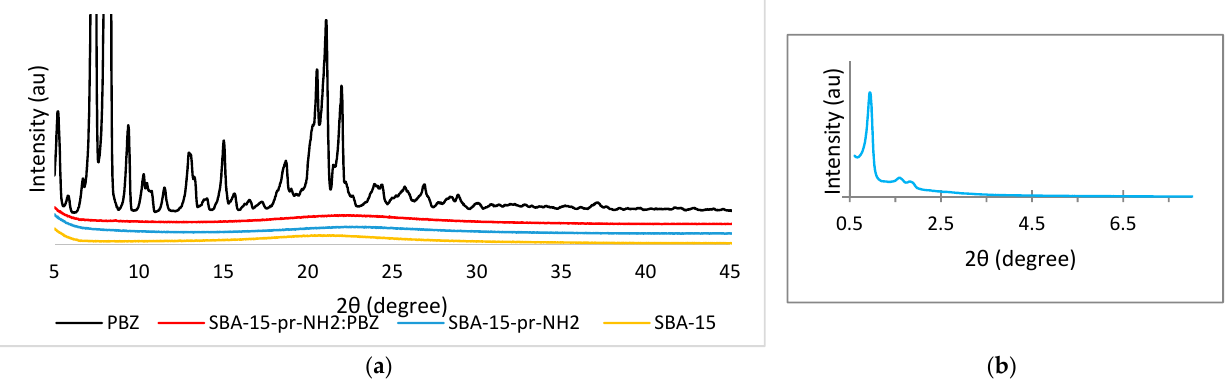
Figure 1. ( a ) Wide-angle XRD patterns of PBZ, SBA-15, SBA-15-pr-NH 2 :PBZ, and SBA-15-pr-NH 2 . ( b ) Small-angle XRD pattern of SBA-15-pr-NH 2 .